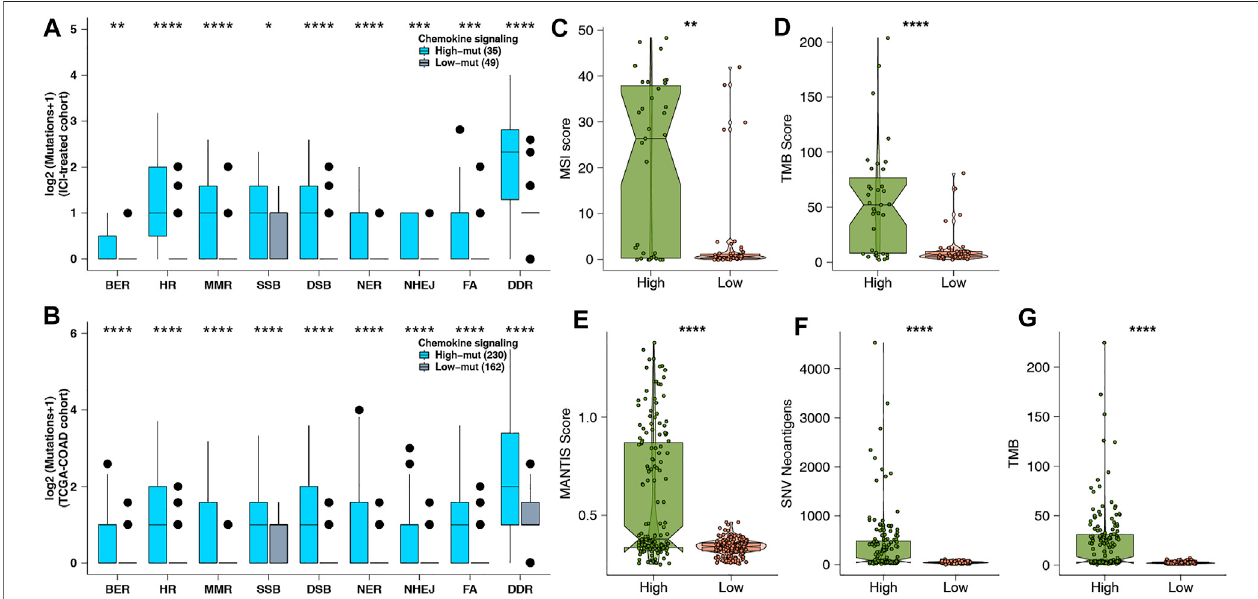
FIGURE 4 | (A) Comparison of DDR signaling alterations between the high-mut and low-mut groups in the ICI-treated cohort (Samstein et al., 2019). (B) ComparisonofDDRsignaling alterationsbetweenthehigh-mutandlow-mutgroupsintheTCGA-COADcohort. (C) ComparisonofMSIbetweenthehigh-mutandlow- mutgroupsintheICI-treatedcohort(Samsteinetal.,2019). (D) ComparisonofTMBbetweenthehigh-mutandlow-mutgroupsintheICI-treatedcohort(Samsteinetal., 2019). (E) Comparison of MSI between the high-mut and low-mut groups in the TCGA-COAD cohort. (F) Comparison of NAL between the high-mut and low-mut groups in the TCGA-COAD cohort. (G) Comparison of TMB between the high-mut and low-mut groups in the TCGA-COAD cohort.